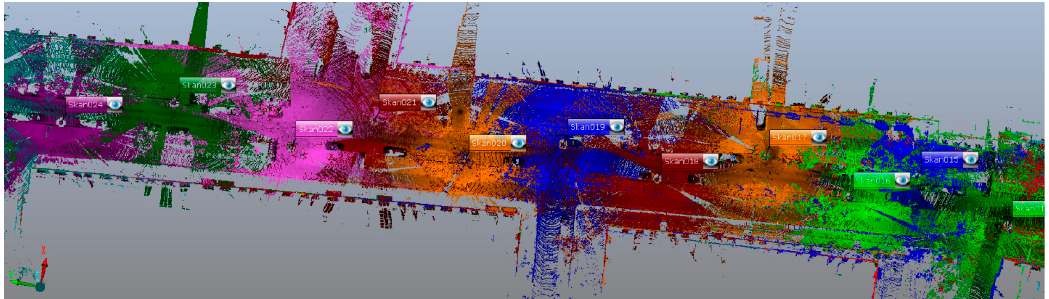
Figure 4. Fragment of obtained street data (stations marked by different colours).